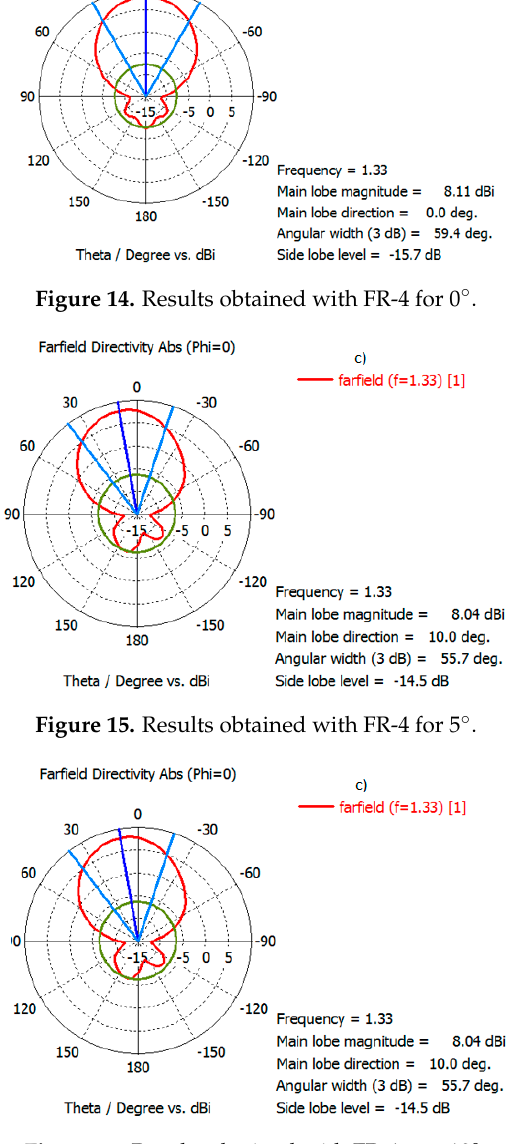
Figure 16. Results obtained with FR-4 to − 10°.